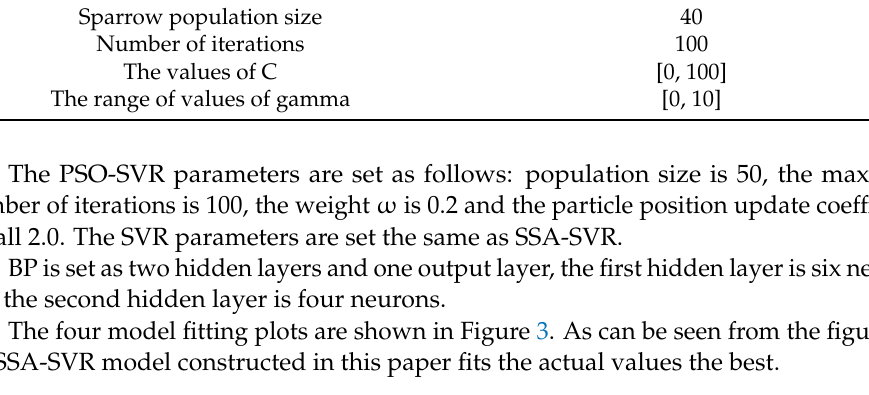
Table 2. Related parameter settings.